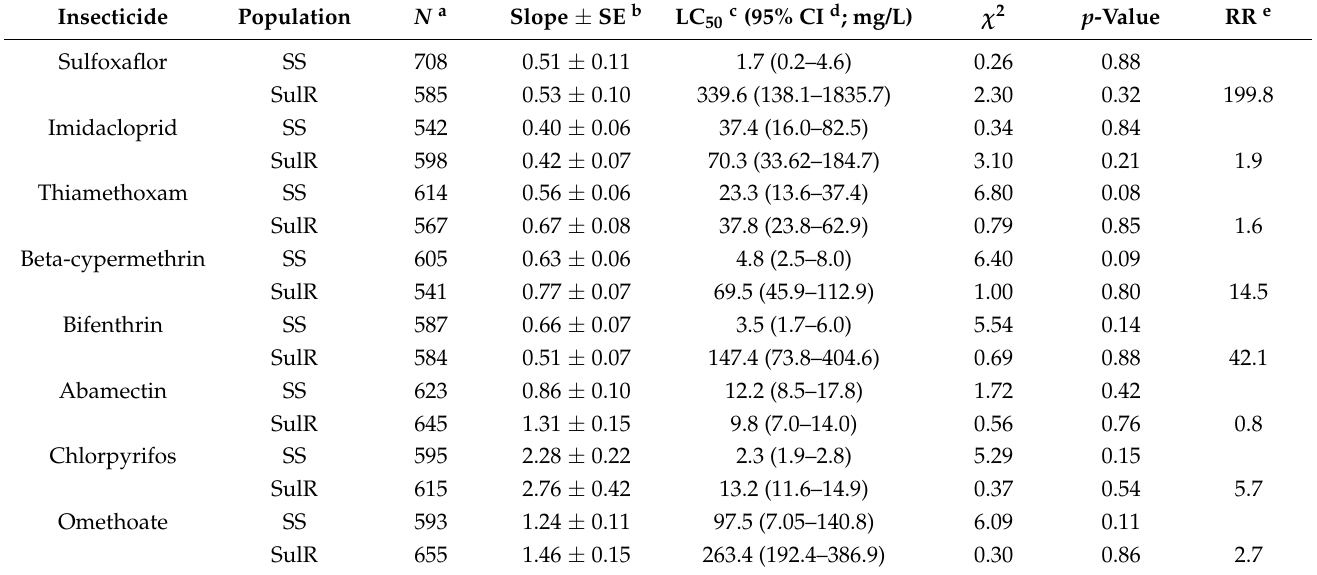
Table 1. Toxicity of the tested insecticides to Sitobion miscanthi field